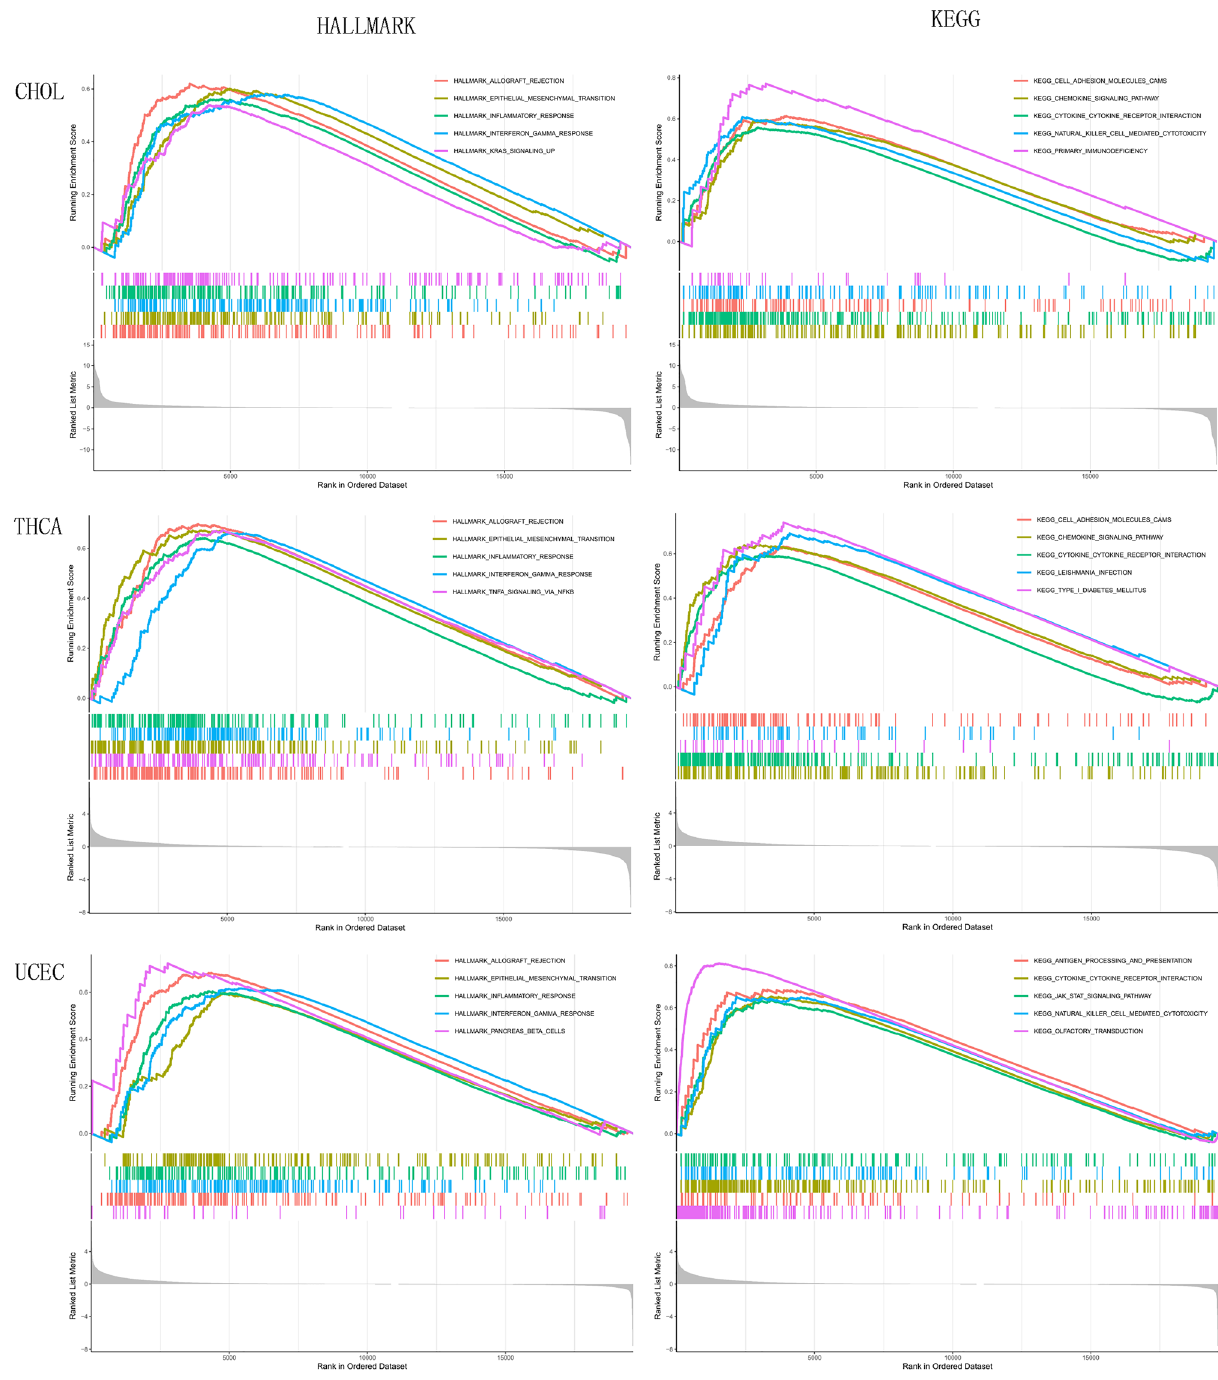
Figure 7. Results of GSEA enrichment analysis. enrichment in CHOL, THCA, UCEC using KEGG and HALLMARK gene